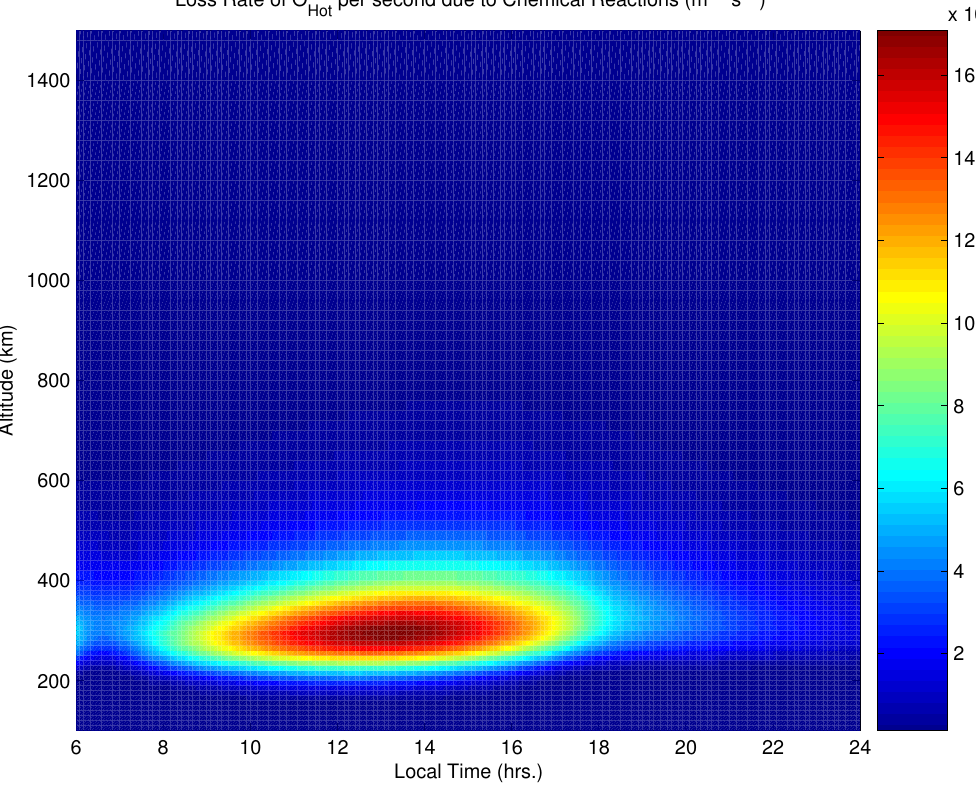
Fig. 6. Loss rate for neutral hot O.